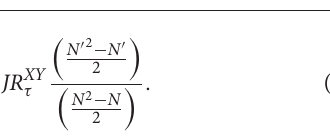
FIGURE 1 | (A) τ 0 time series for 36 Rössler systems in the phase coherent regime with randomized initial conditions using JRQA-based TDS ( τ jr 0 ) with ν set to 0.04 and k set to 0.15. The time starts at 48s as this is the last time point in the first TDS window (with a window size set to 48s with a 4.8s advance). The dotted black line marks the time coupling was initiated between the systems. Different instantiations of the systems are represented by different colored lines; the dark blue line is the mean and the error bars are 95% confidence intervals. (B) The same systems evaluated with cross-correlation-based TDS ( τ C 0